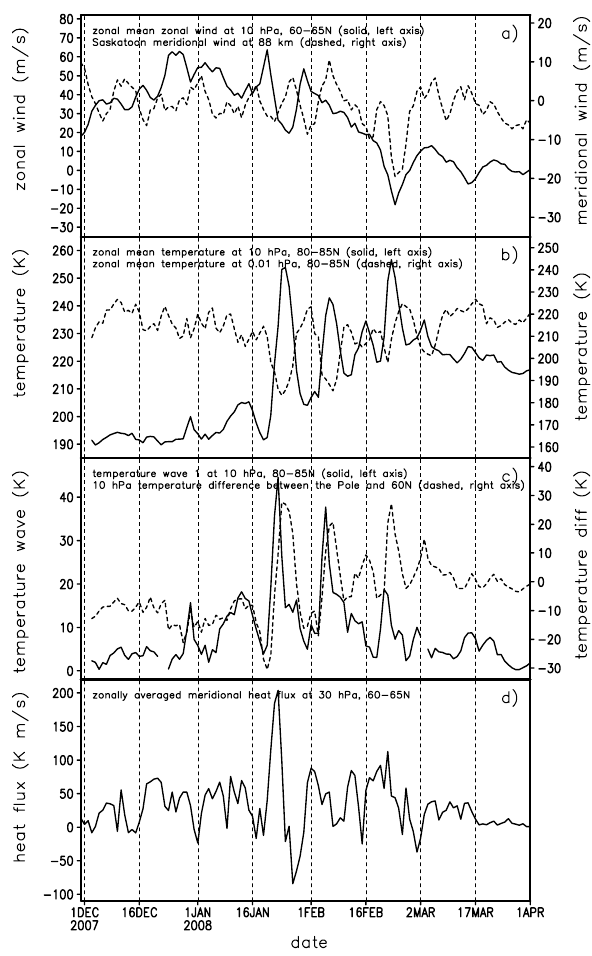
Fig. 6. As in Fig. 1, but for the 2007/2008 winter.